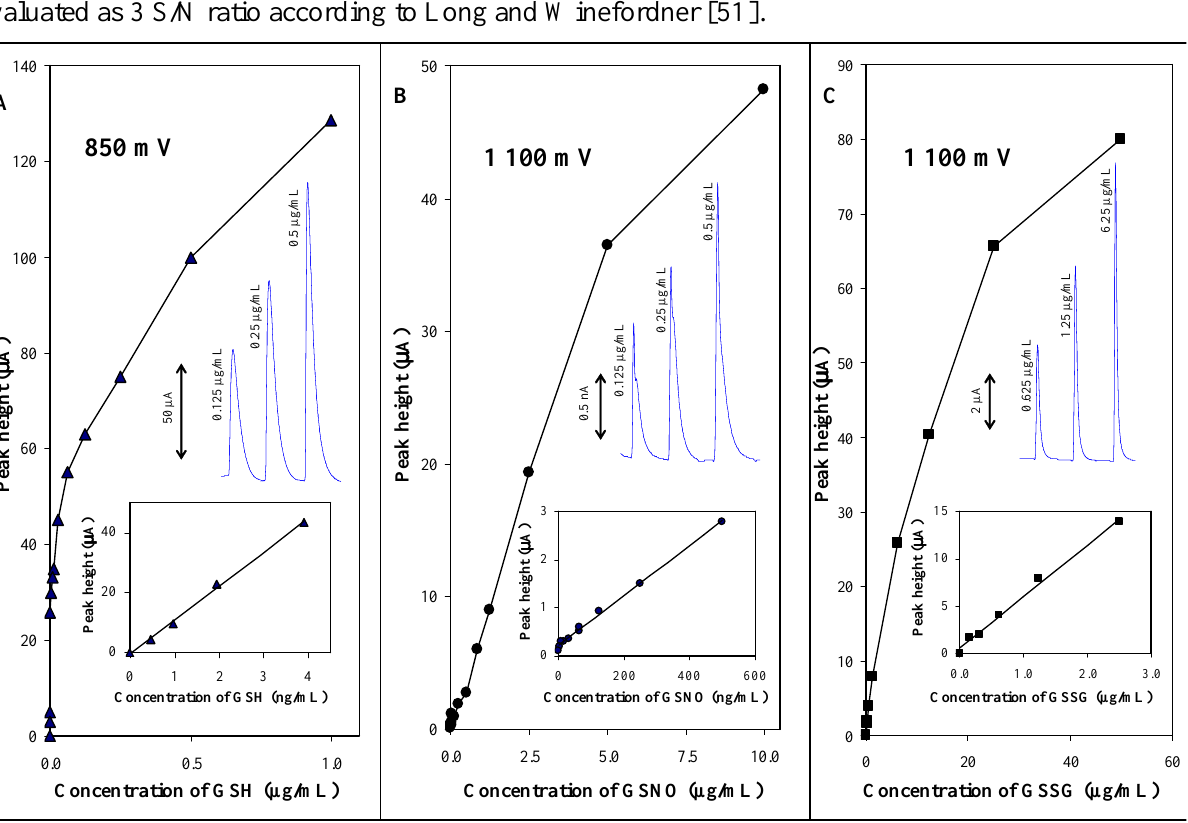
Figure 4. Dependences of peak heights of GSH ( A ), GSSG ( B ) and GSNO ( C ) on their concentrations; insets: calibration dependences of the thiols and real chromatograms. For other details see Fig.